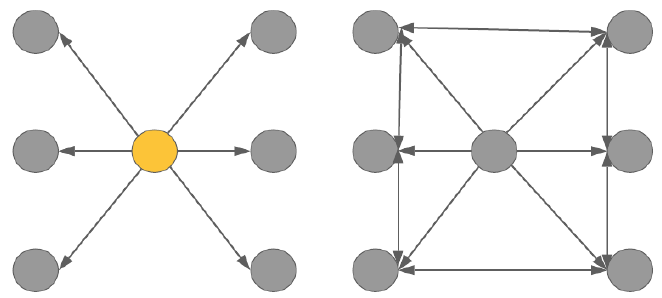
Figure 2. Centralized and distributed localization.